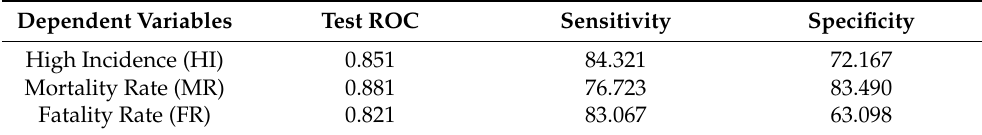
Table 2. Evaluation of the modeling concerning the sensitivity and specificity of the ROC test for the period’s high incidence, mortality rate, and the fatality rate for COVID-19 in the years 2020 and 2021, Brazil. Dependent Variables Test ROC Sensitivity Specificity High Incidence